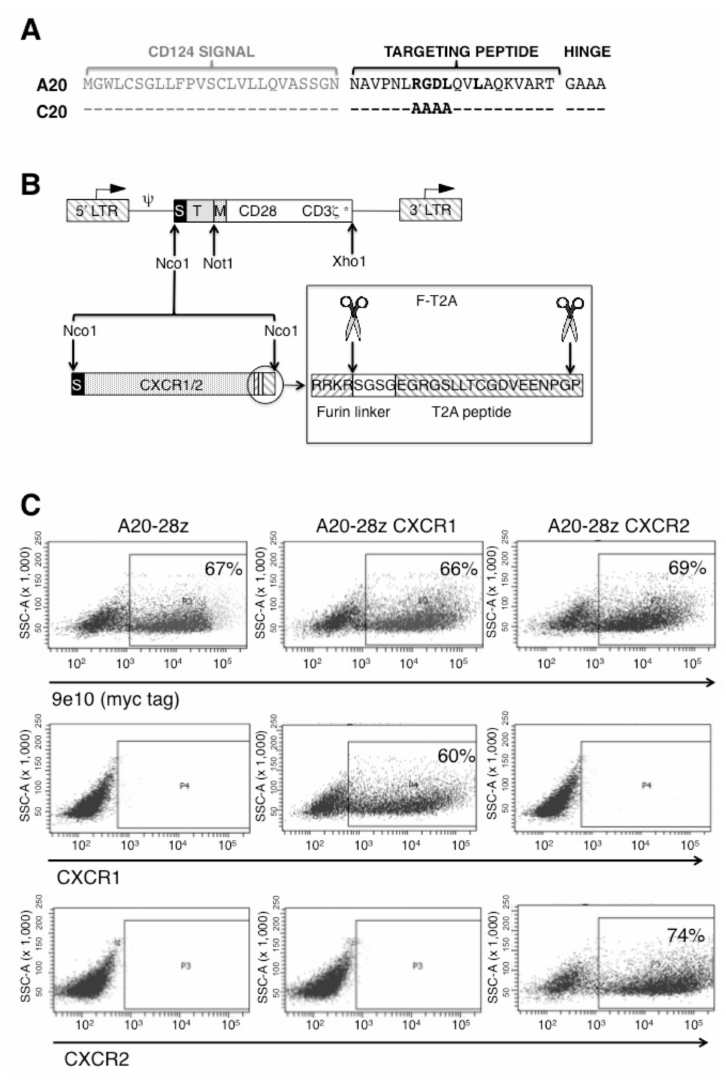
Figure 2. Design of retroviral constructs. ( A ) In order to engineer an α v β 6-targted chimeric antigen receptors (CAR), the A20 peptide derived from the capsid protein VP1 from Foot and Mouth Disease Virus (serotype 01 BFS) was placed downstream of a CD124 signal peptide. A matched but scrambled peptide (named C20) was generated in which RGDL was replaced with AAAA. ( B ) The SFG retroviral vector was used to express CARs in human T-cells. LTR: long terminal repeat; S: signal peptide; T: